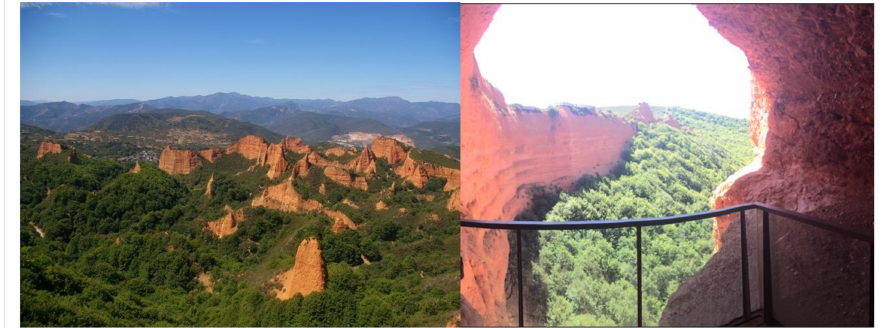
Figure 3. Views from the Orell á n de Las M é dulas viewpoint (Castilla y Le ó n). Source: Author’s